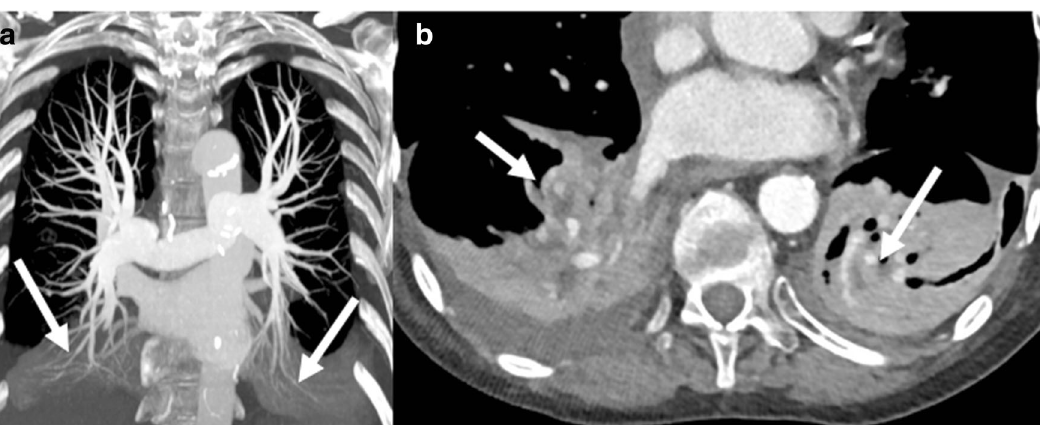
Fig. 6 Donor – recipient size mismatch. Persisting dyspnea. Atelectasis of lower lobes ( arrows in a ) with comet-tail sign ( arrows in b